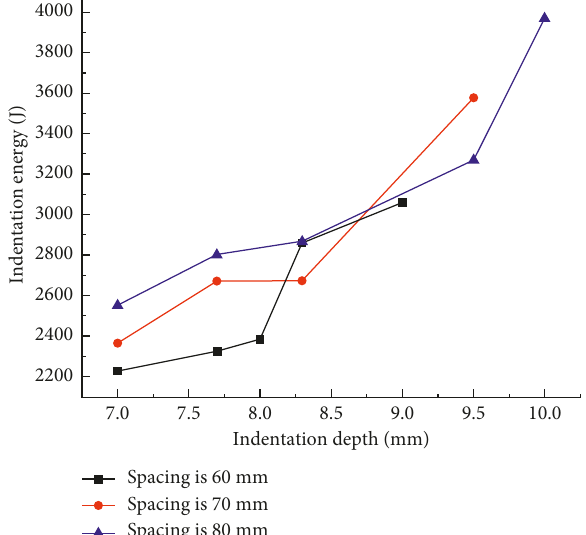
Figure 6: The indentation energies for various indentation tests.